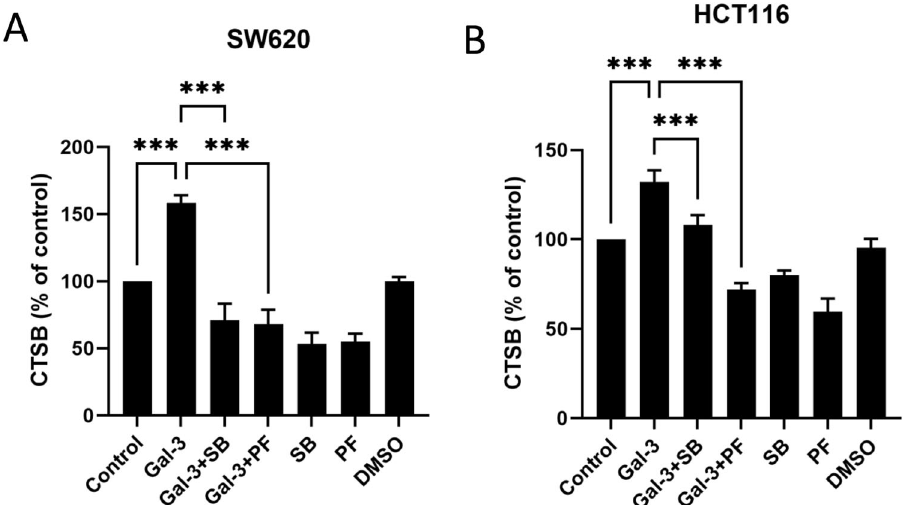
Fig. 8 Galectin-3 induces CTSB secretion through PYK2-GSK3 α / β activation. SW620 ( A ) and HCT116 ( B ) cells were treated with 10 µg/ml galectin-3 or BSA without or with SB216763 (SB), PF431396 (PF) or DMSO overnight. The concentrations of cathepsin-B in the supernatants were analysed by ELISA. Data are presented as mean ± SEM of three independent experiments. *** P < 0.001, ** P < 0.01, * P < 0.05